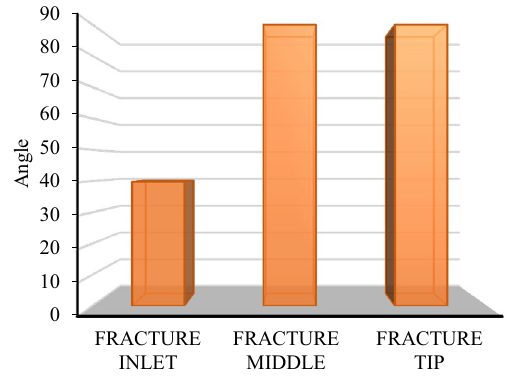
Fig. 4 Gel propagation angles (gel particle size to fracture width ratio is 6.4)